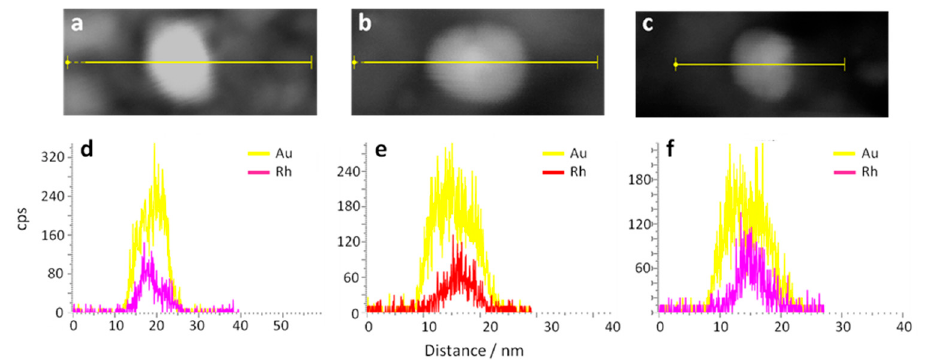
Figure 3. STEM images of selected bimetallic particles: ( a ) AuRh(3:1) / Al 2 O 3 , ( b ) AuRh(1:1) / Al 2 O 3 , and ( c ) AuRh(1:3) / Al 2 O 3 . Energy-dispersive X-ray spectroscopy (EDX) line scans of selected bimetallic particles: ( d ) AuRh(3:1) / Al 2 O 3 , ( e ) AuRh(1:1) / Al 2 O 3 , and ( f ) AuRh(1:3) / Al 2 O 3 .